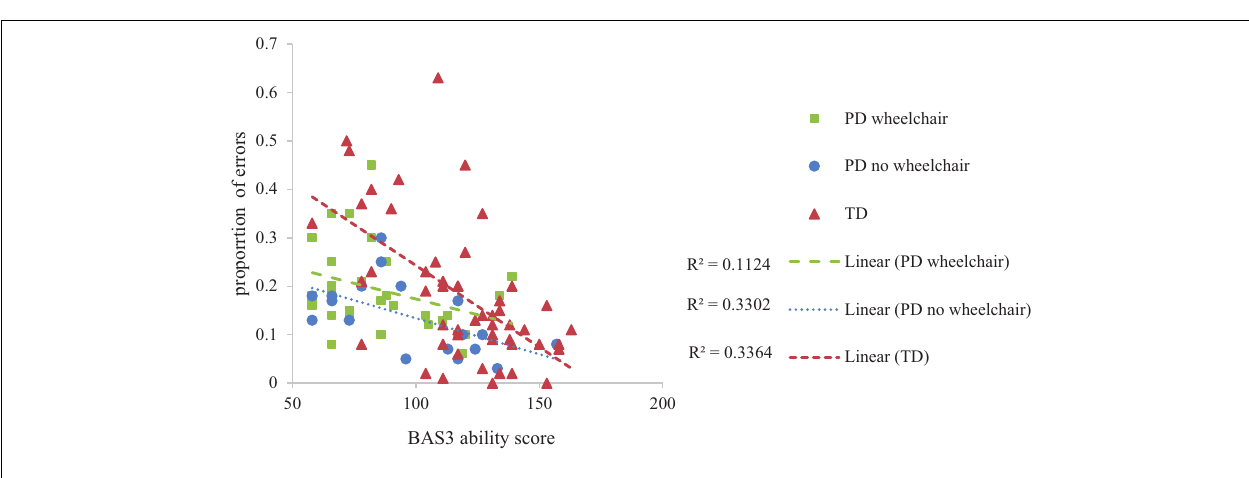
FIGURE 6 | Developmental trajectory of proportion of spatial programming errors per route attempted.